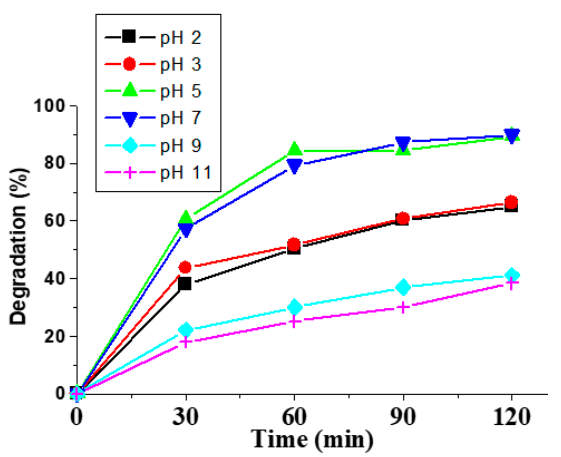
Figure 10. Effect of pH on photodegradation of Congo red dye over [Ag 0.05 ZnO 0.05 V 2 O 5(0.90) ].